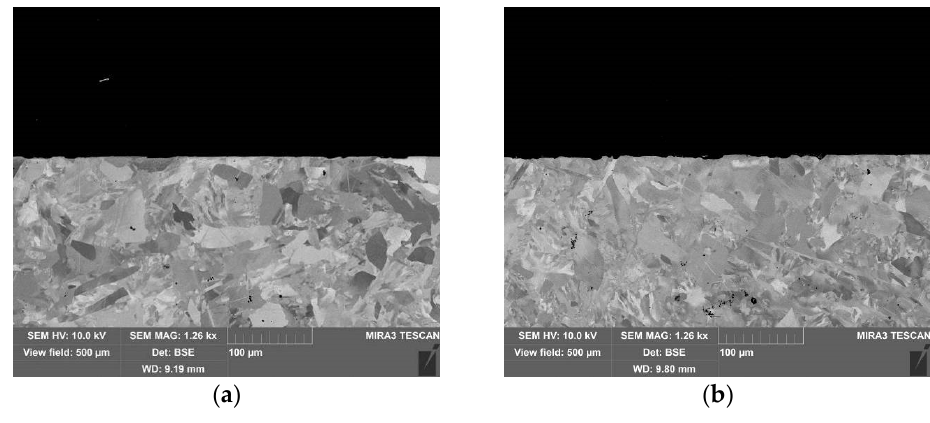
Figure 6. Microstructure of cast steels 20 GL ( a ) and 30 L ( b ).